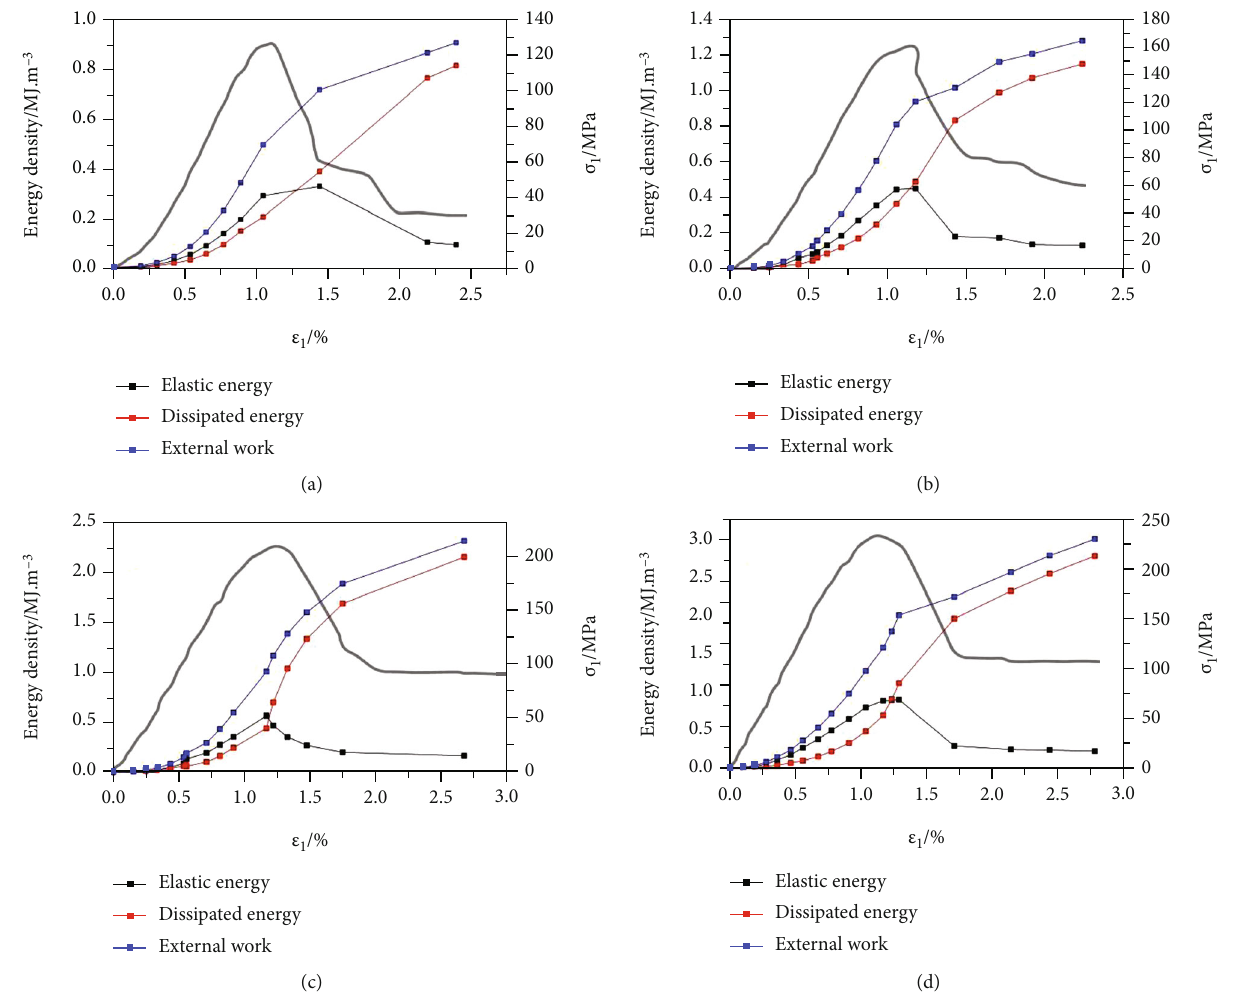
Figure 10: Energy evolution curves under di ff erent con fi ning pressures ((a) 5 MPa, (b) 10 MPa, (c) 20MPa, and (d) 30